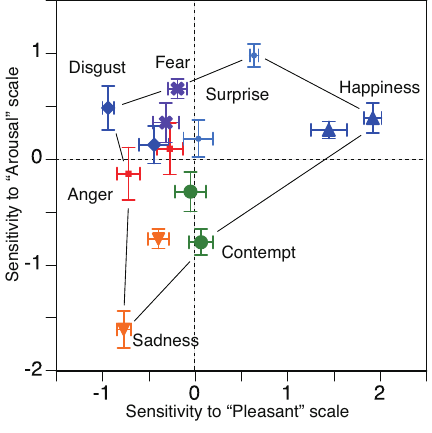
Figure 10. Relationship between Sensitivity to emotional metrics and Predicted values.